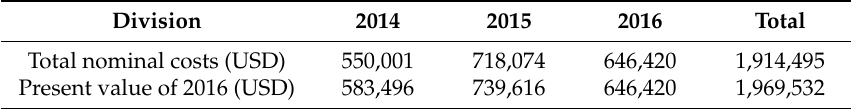
Table 2. Present value of intervention costs of the MCH project in the